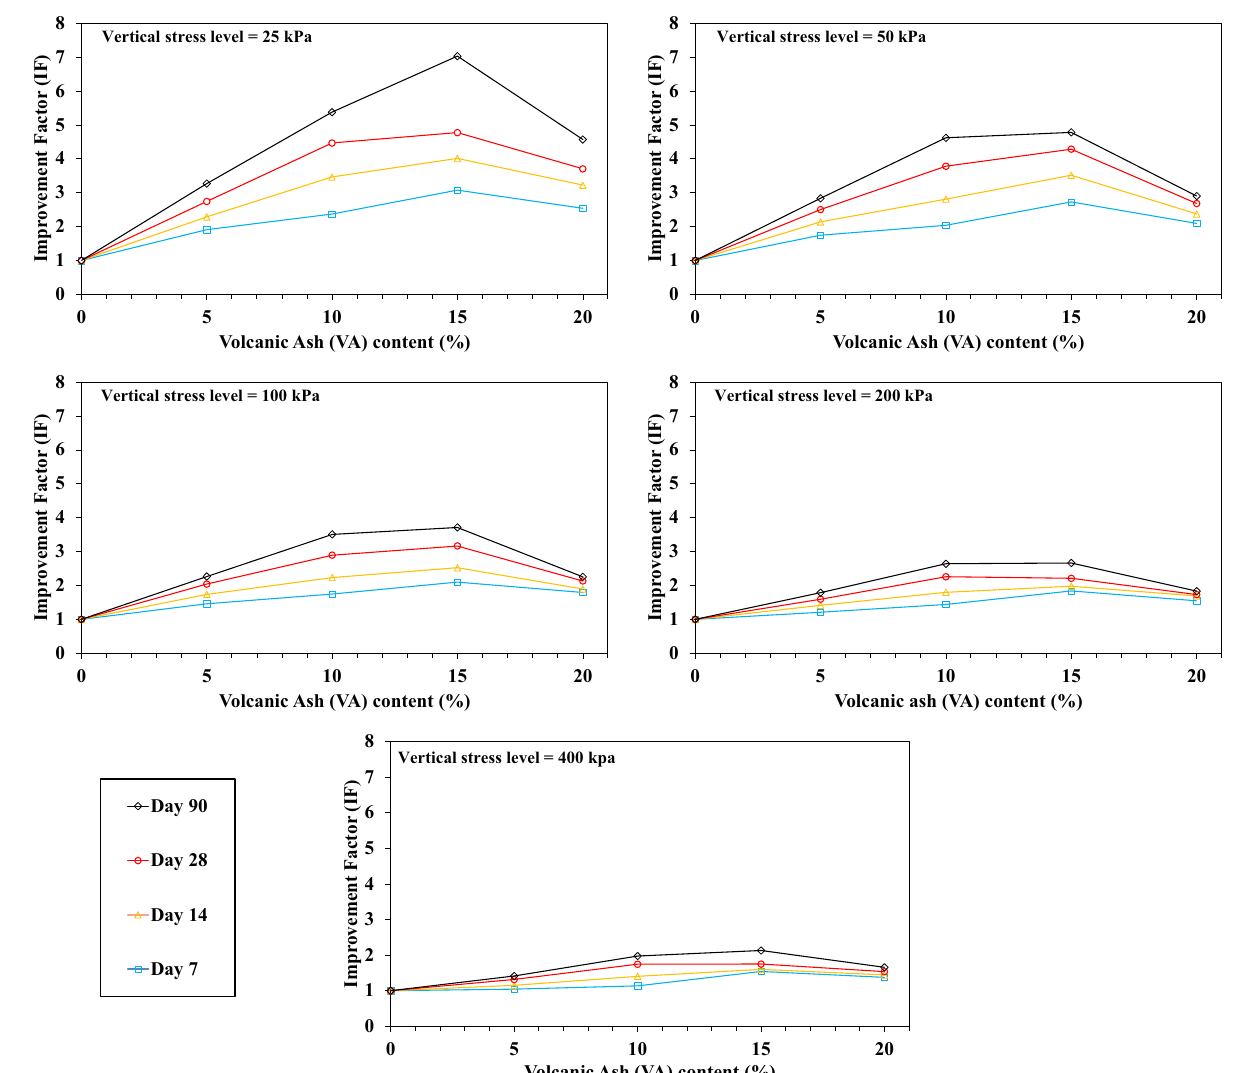
Figure 11. Influence of the volcanic ash (VA) content on the improvement factor (IF) at the optimum moisture content (OMC)